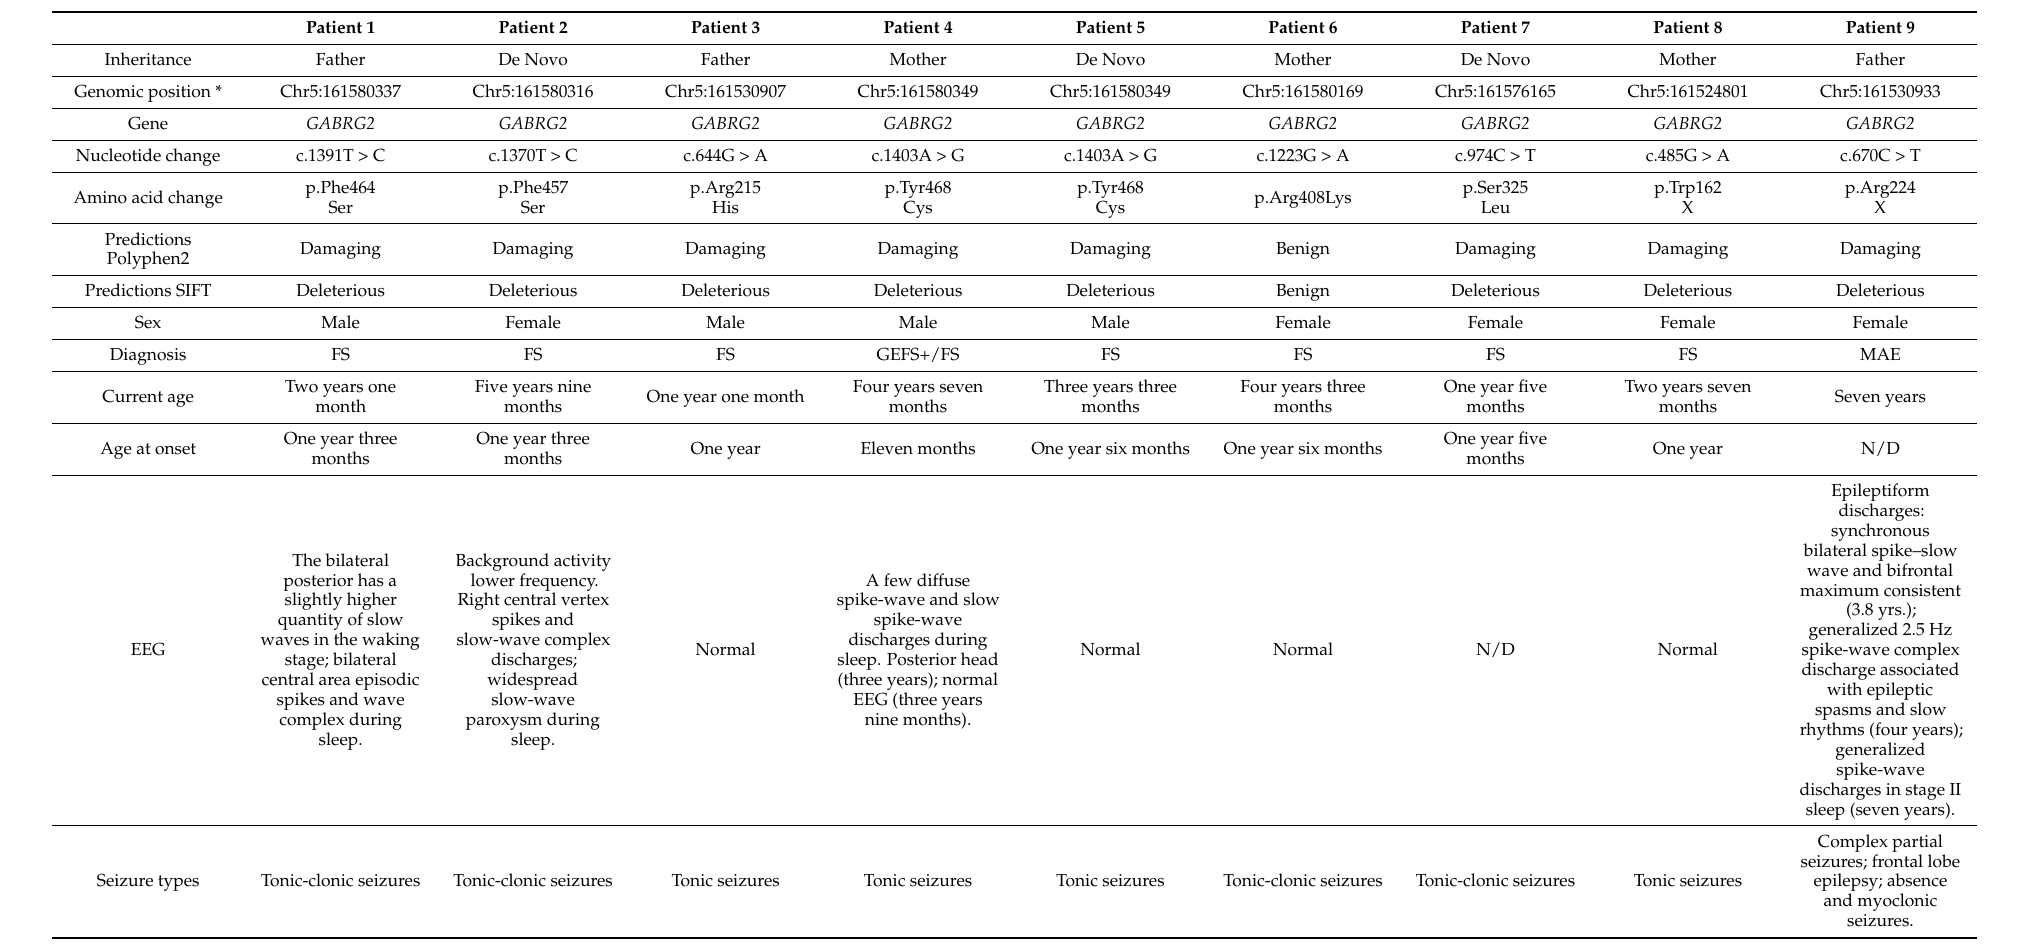
Table 1. Genetic and clinical features of patients carrying GABRG2